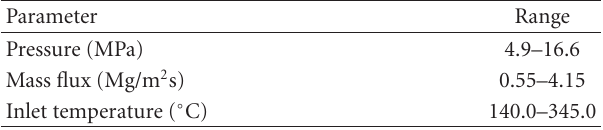
Table 1: Summary of facility [1].